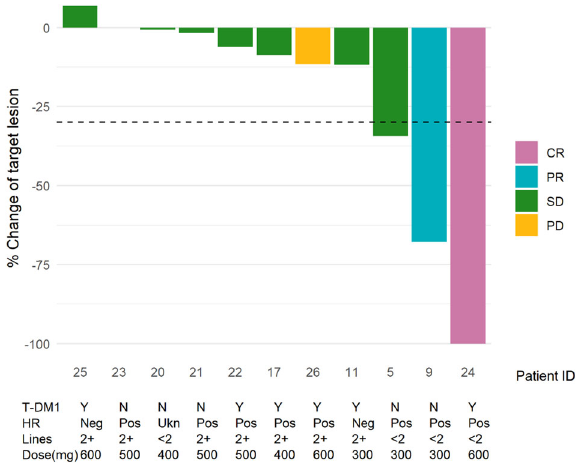
Fig. 1 Waterfall plot demonstrating objective response rates for study participants. The median follow-up time was 12.4 months (95% CI: 2.7 – 15.4). One patient without a target lesion was excluded from this fi gure. Prior T-DM1 use (Y yes, N no), hormone receptor (HR) status, number of lines of prior therapy, and assigned dose of ribociclib are notated below the X -axis. PD progressive disease, CR complete response, PR partial response, SD stable disease, Neg negative, Pos positive, Ukn unknown.